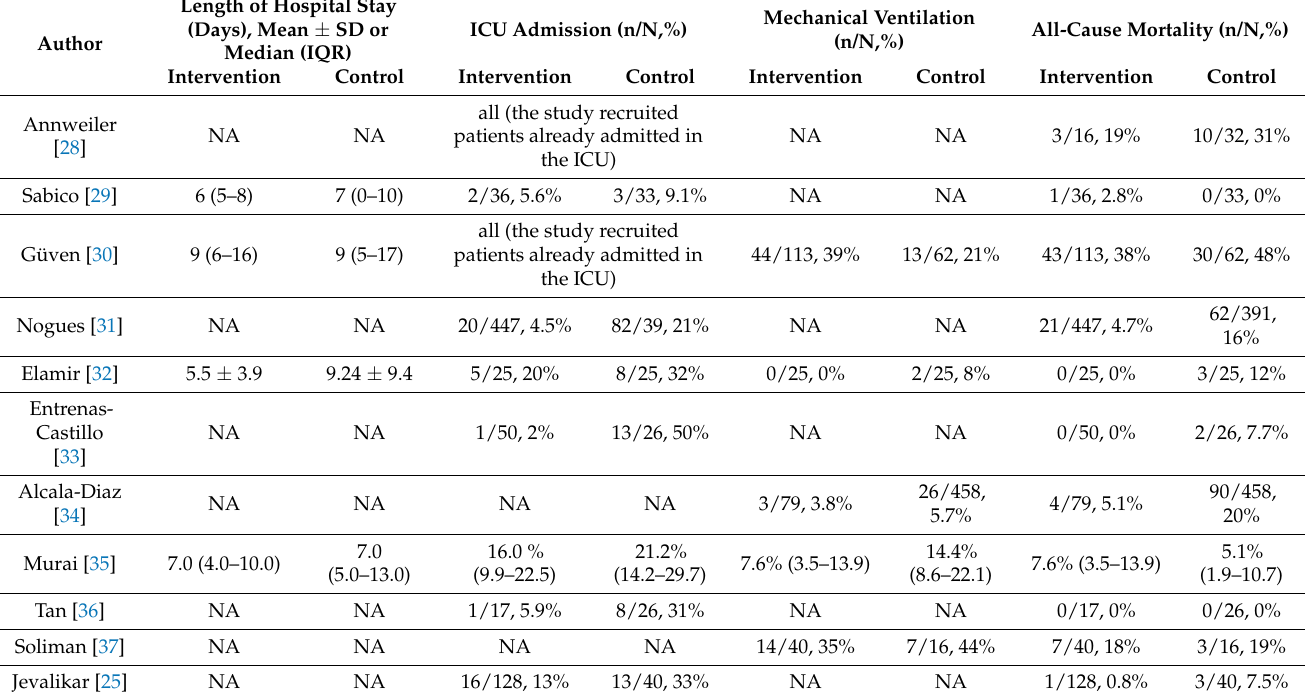
Table 2. Patient